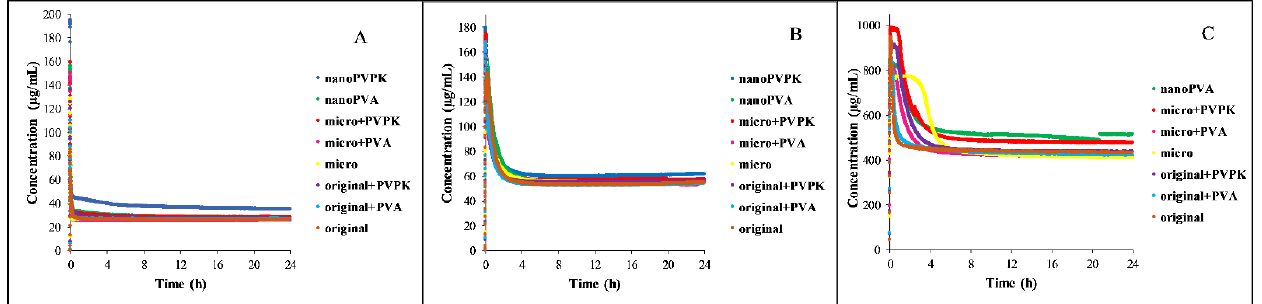
Figure 2. Dissolution profile of papaverine hydrochloride in FaSSIF blank ( A ), FaSSIF full ( B ) and FeSSIF blank ( C ) medium.